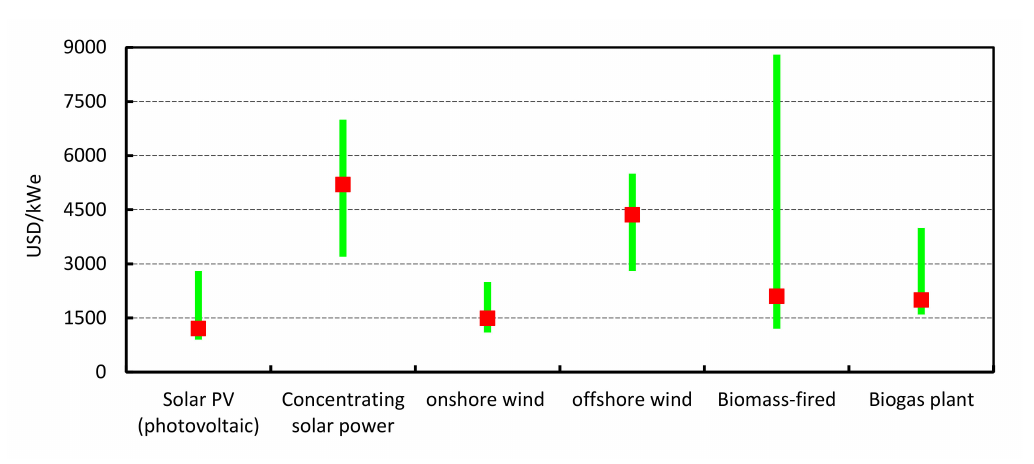
Figure 4. Specific investment costs for renewable plants.